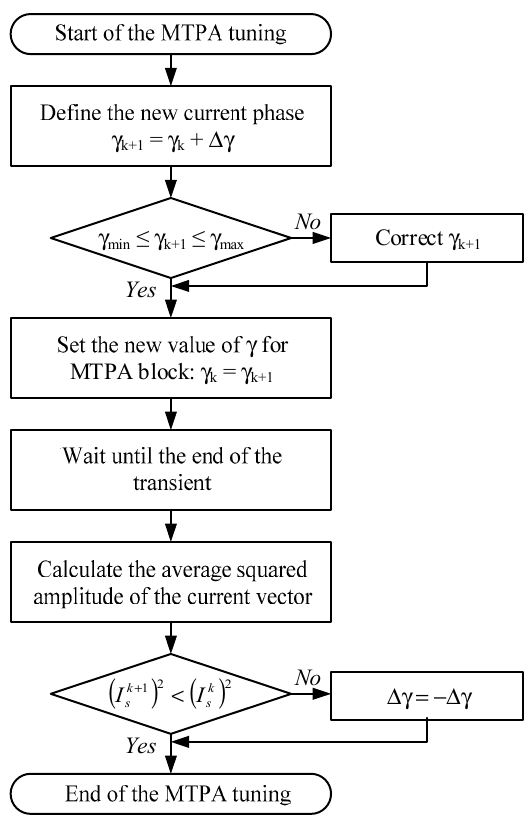
Figure 1. Flowchart of the MTPA seeking algorithm.